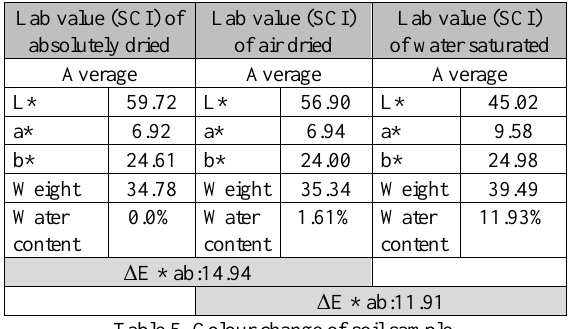
Table 5. Colour change of soil sample.